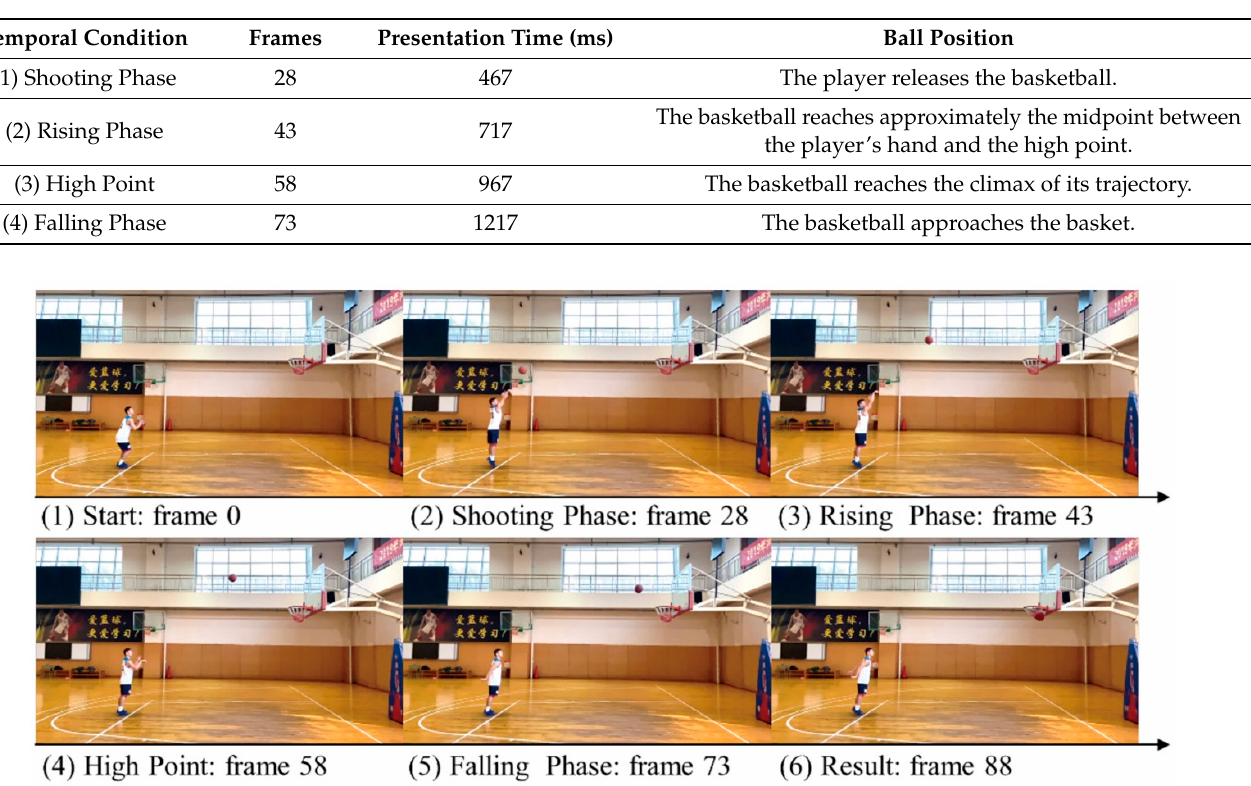
Figure 1. Example of the experimental stimuli. Written informed consent was obtained for the publication of this image.